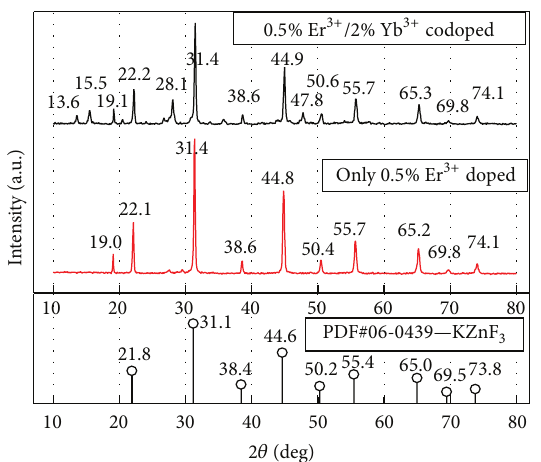
Figure 1: X-ray diffraction pattern of the Er 3+ , Er 3+ /Yb 3+ doped nanocrystals and the standard KZnF 3 XRD